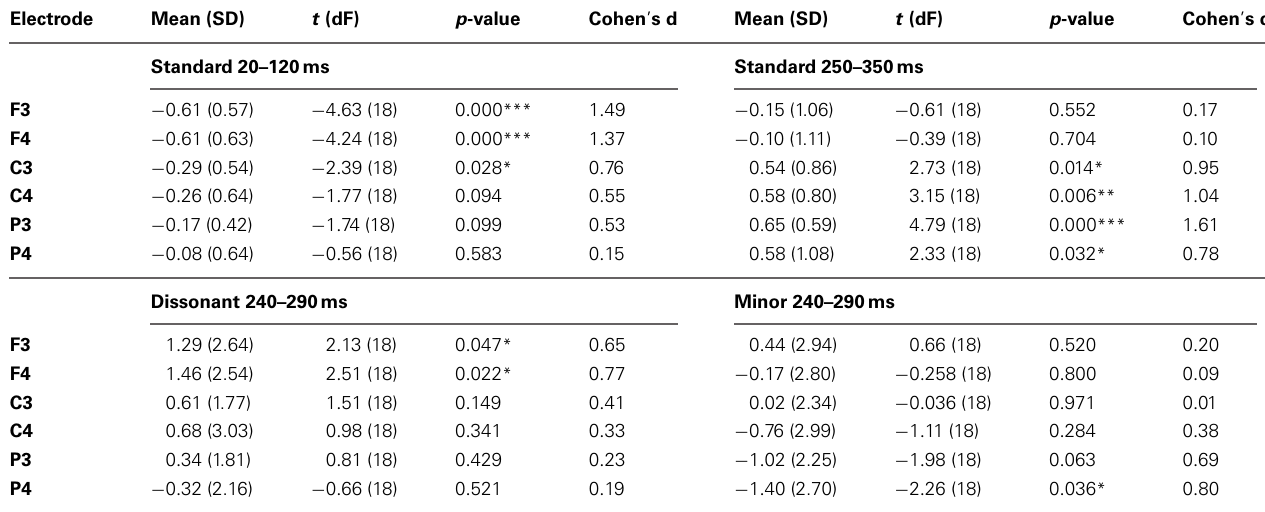
Table 3 | The mean amplitude in µ V (standard deviation) on the specified time window for the standard and deviant-minus-standard responses tested with one-sample t